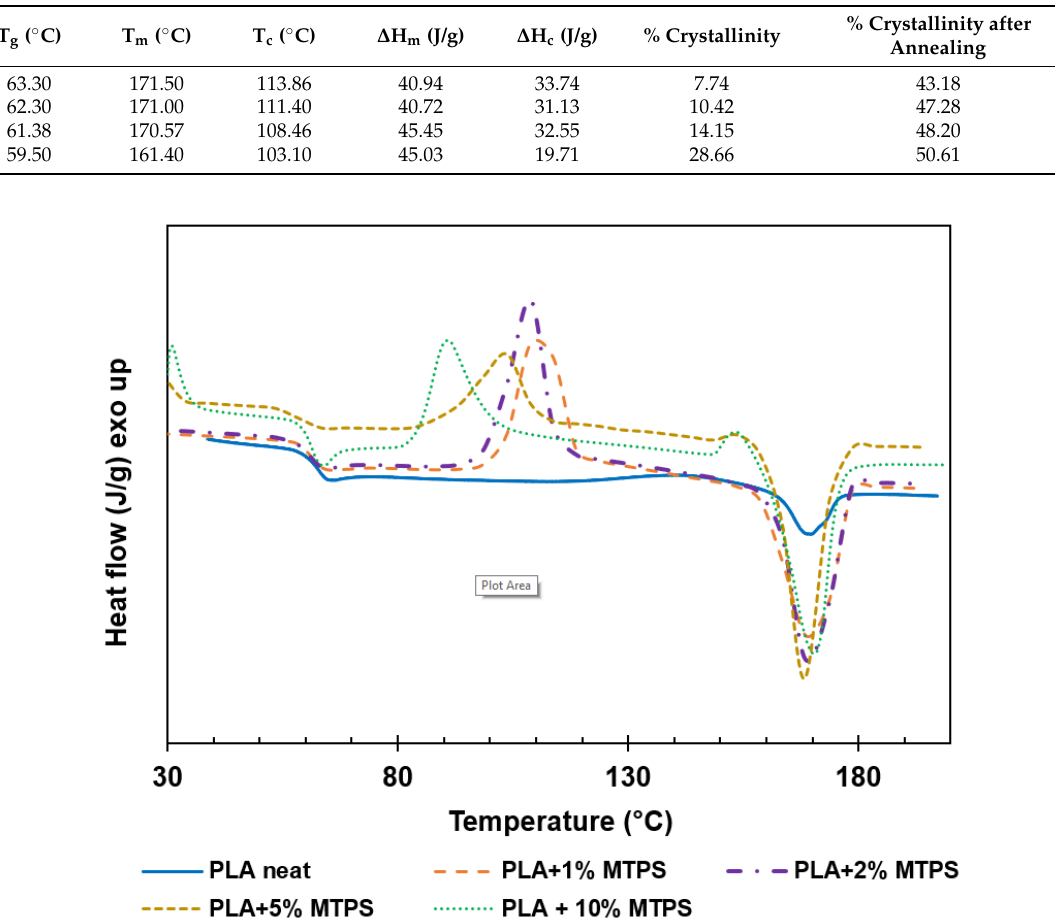
Table 7. Thermal transition temperatures and percent crystallinity of modified PLA samples.